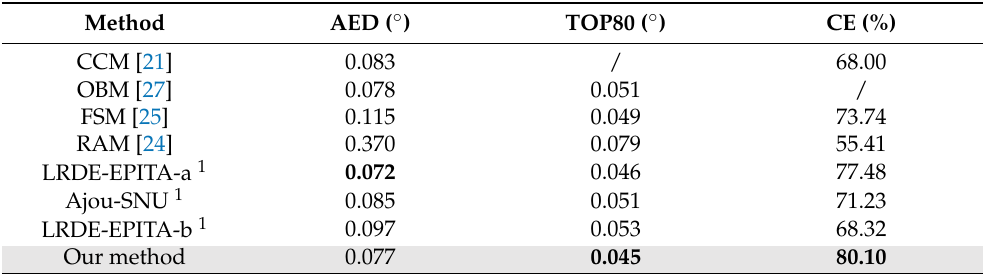
Table 6. Comparison results for Chengtao Cai’s method (CCM), Omar boudraa’s method (OBM), Felix Stahlberg’s method (FSM), Riaz Ahmad’s method (RAM), and other algorithms based on the DISEC’2013 dataset with our method for using the DISEC’2013 dataset.